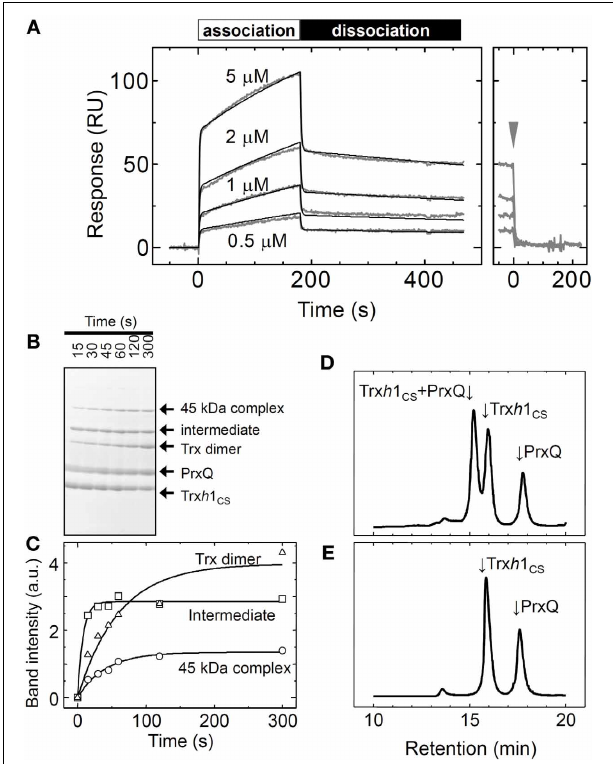
FIGURE 3 | Interaction between the oxidized form of the PrxQ and Trx h 1 CS proteins. (A) Same experiment as presented in Figure 2A , except using PrxQ as the analyte. (B) Trx h 1 CS (50 μ M) and PrxQ (50 μ M) were incubated for the periods indicated. The reaction was then quenched with 5% TCA (w/v). Proteins were separated by non-reducing SDS-PAGE. (C) Band intensities of the mixed disulfide intermediate complexes (intermediate), 45kDa complexes, and the Trx h 1 CS dimers (Trx dimer) obtained from SDS-PAGE presented in panel (B) were determined using a Scion image software and plotted. a.u.; arbitrary units. (D) Trx h 1 CS (50 μ M) and oxidized PrxQ (50 μ M) were incubated for 3min at room temperature, and the complexes that formed were then incubated with 10mM NEM. The protein mixture was then loaded onto G2000SW XL and separated. (E) Same experiment as in (D) except for incubation in the absence of